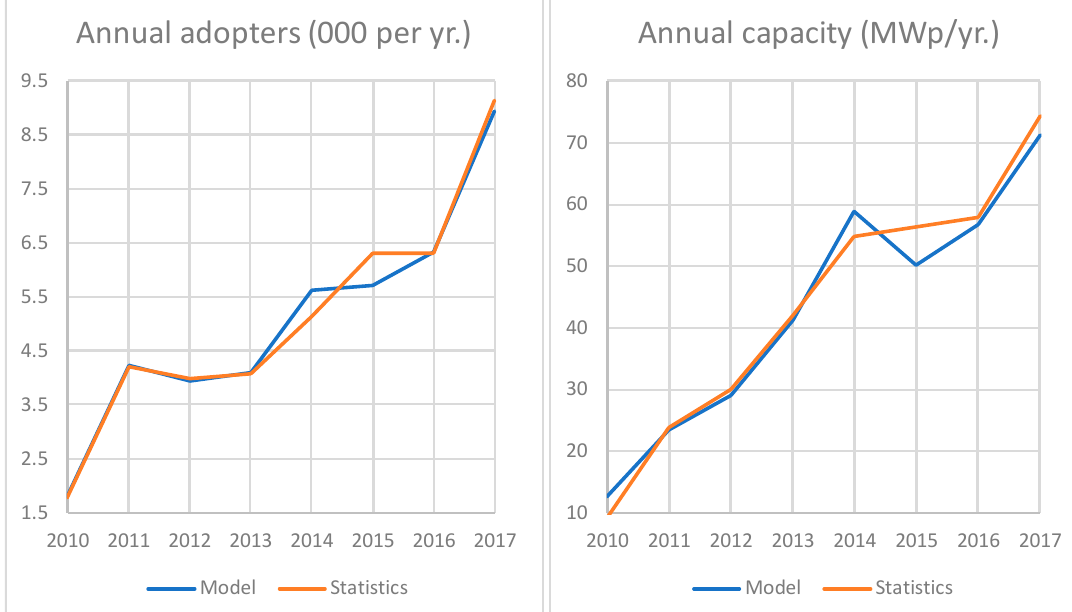
Figure B 2 . Comparison of the model results and actual statistics during the calibration and validation period of 2010 – 2017, regarding annual adopters (left) and annual installed capacity (right); the year of 2009 is not shown here, because it represents the initial conditions to start the simulation (i.e., both the adopters and the installed capacities are exogenously given to the model).